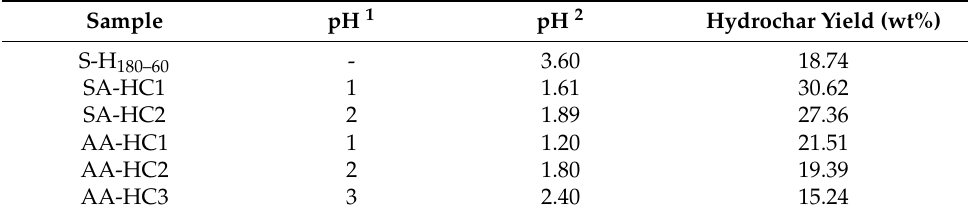
Table 3. Hydrochar yields as a function of initial